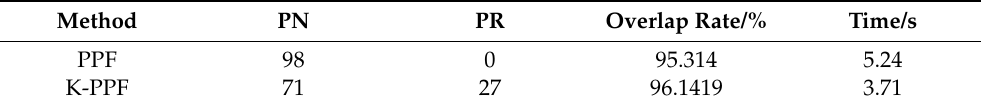
Figure 10. Sampling point comparison display ( a ) K-PPF, red is the sampling point; ( b ) PPF, blue is the sampling point. Table 1. Comparison of algorithms: PN is the average number of scenes matching point pair features; PR is the average number of matching point pair features reduced in each scene by K-PPF compared to PPF.